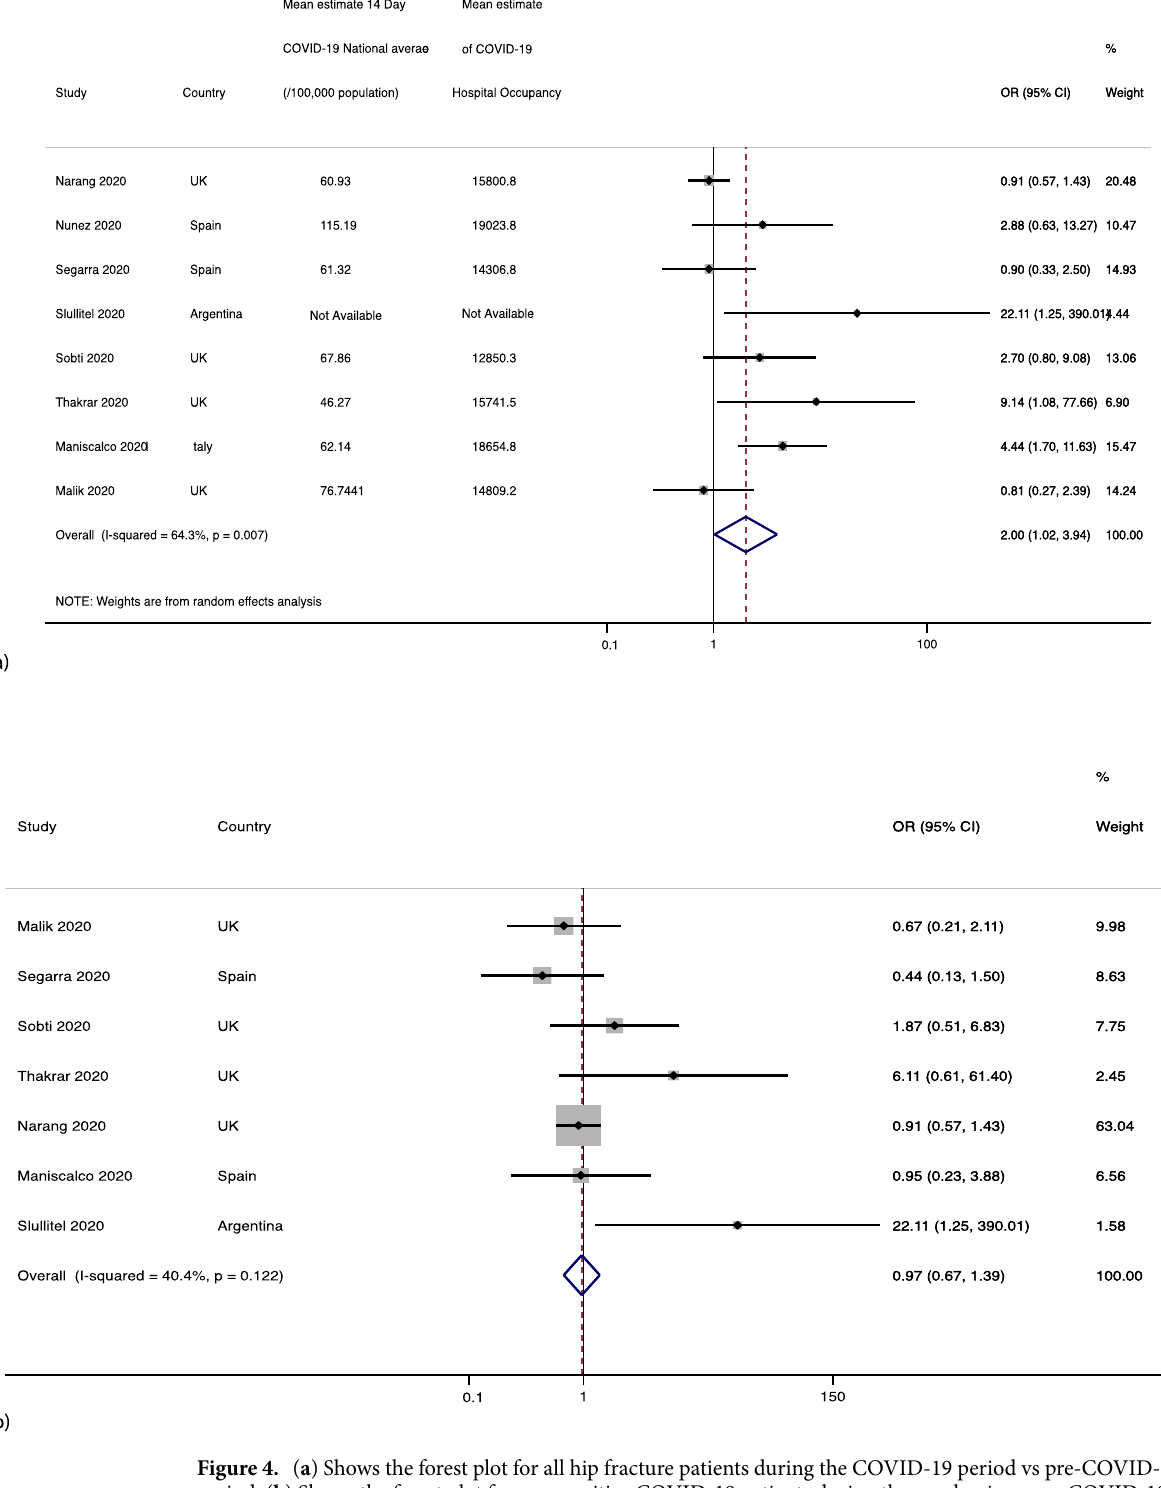
Figure 4. ( a ) Shows the forest plot for all hip fracture patients during the COVID-19 period vs pre-COVID-19 period. ( b ) Shows the forest plot for non-positive COVID-19 patients during the pandemic vs pre-COVID-19